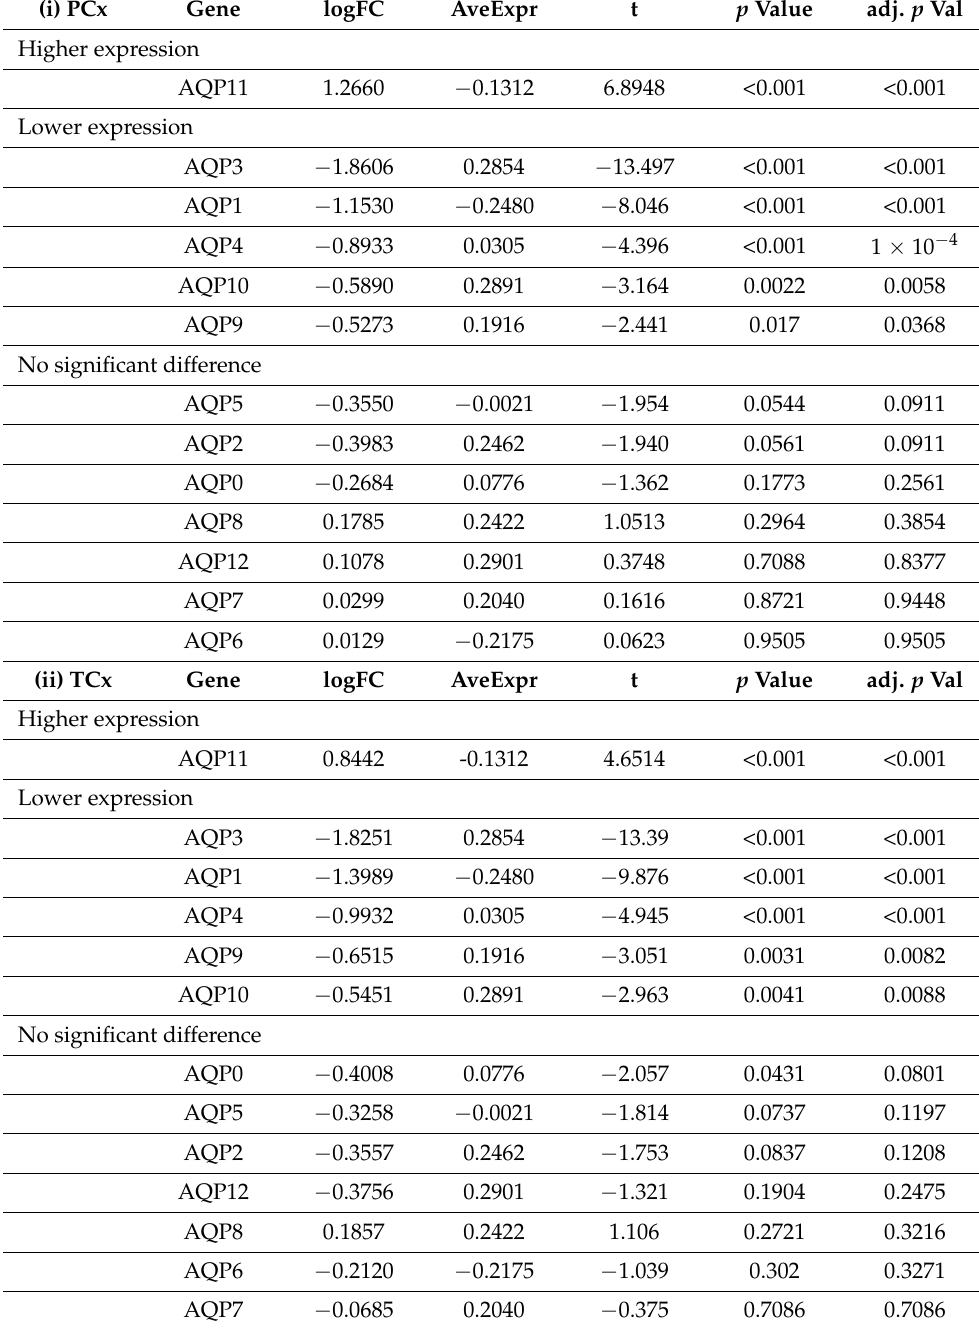
Table 2. AQP transcript expression levels in cortical regions differ from those in the hippocampal formation. Differential expression analysis of AQPs in the (i) PCx and (ii) TCx as compared with HIP for subjects in the combined C and AC groups. The average expression (AveExpr) was determined by averaging all RNAseq levels over all probes used for the indicated gene. t-values represent the test statistic associated with the comparison of the two means using two-sample t -tests, with positive values indicating a larger average RNAseq in the cortical region compared to the hippocampus. p values were adjusted (Adj P) for multiple tests using the Bonferroni correction, with significant differences indicated as p <